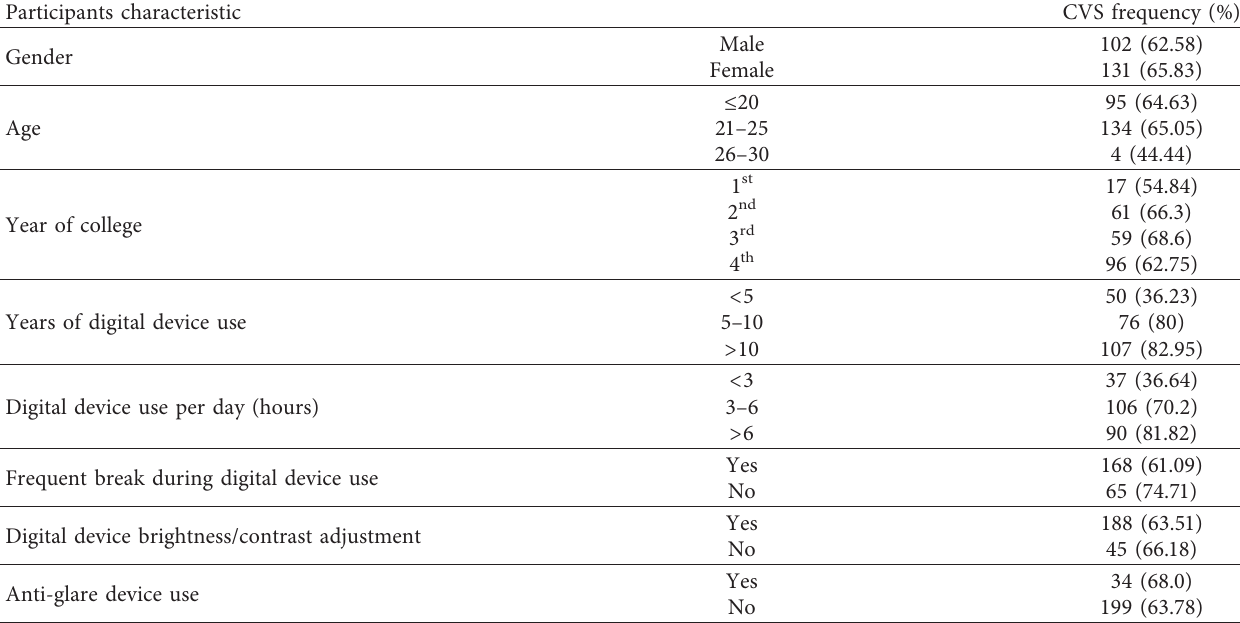
Table 3: CVS by participant characteristics and digital device use behavior.